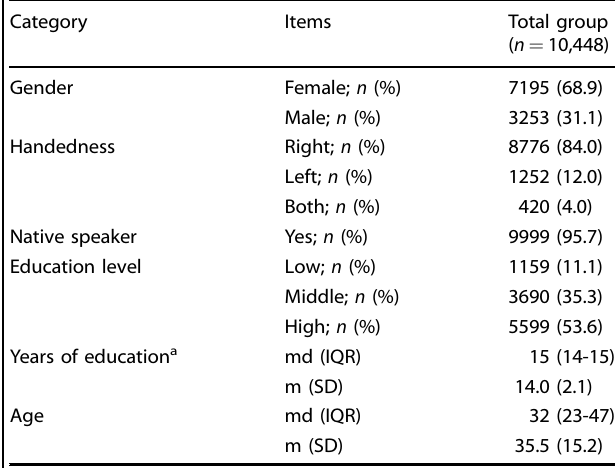
Table 1. Demographic characteristics of the entire study sample ( n =